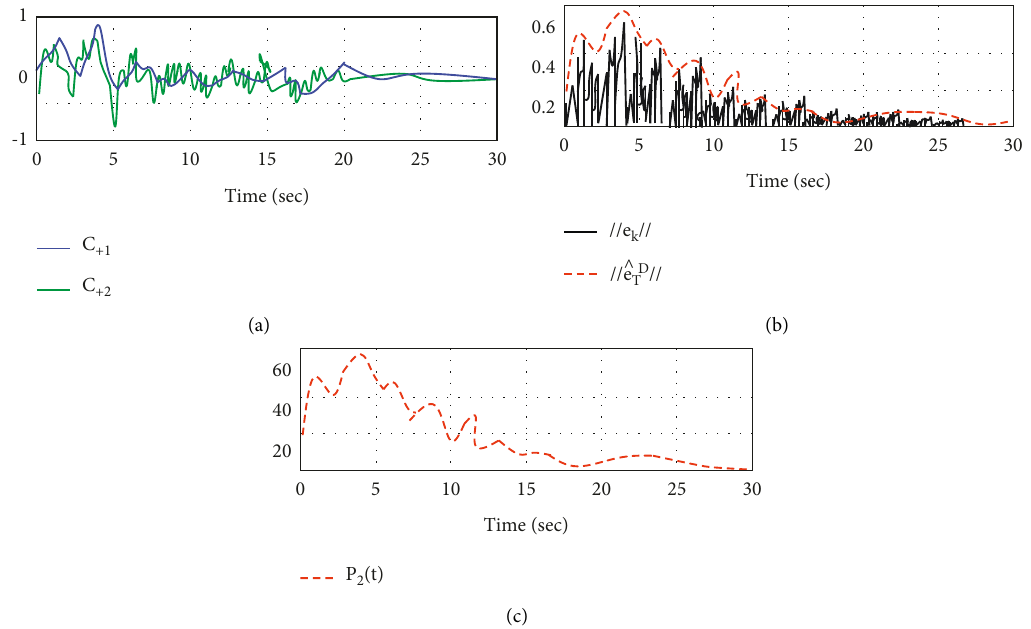
Figure 4: (a). Tracking error of nominal system. (b). Sampling error and trigger threshold of nominal system. (c). Internal dynamic signal.